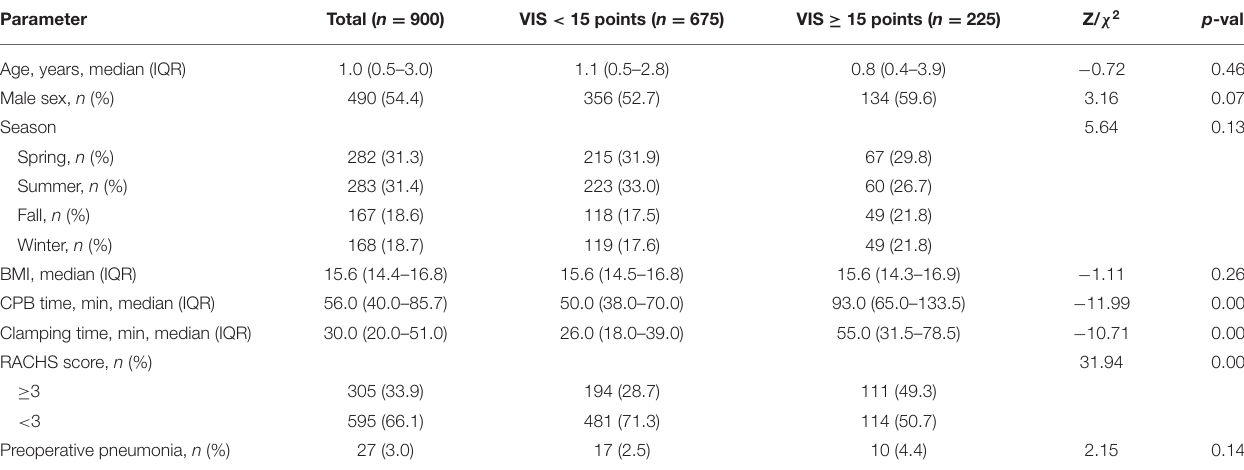
TABLE 2 | Demographic and clinical characteristics of study participants according to postoperative VIS max during the first 24h after surgery.